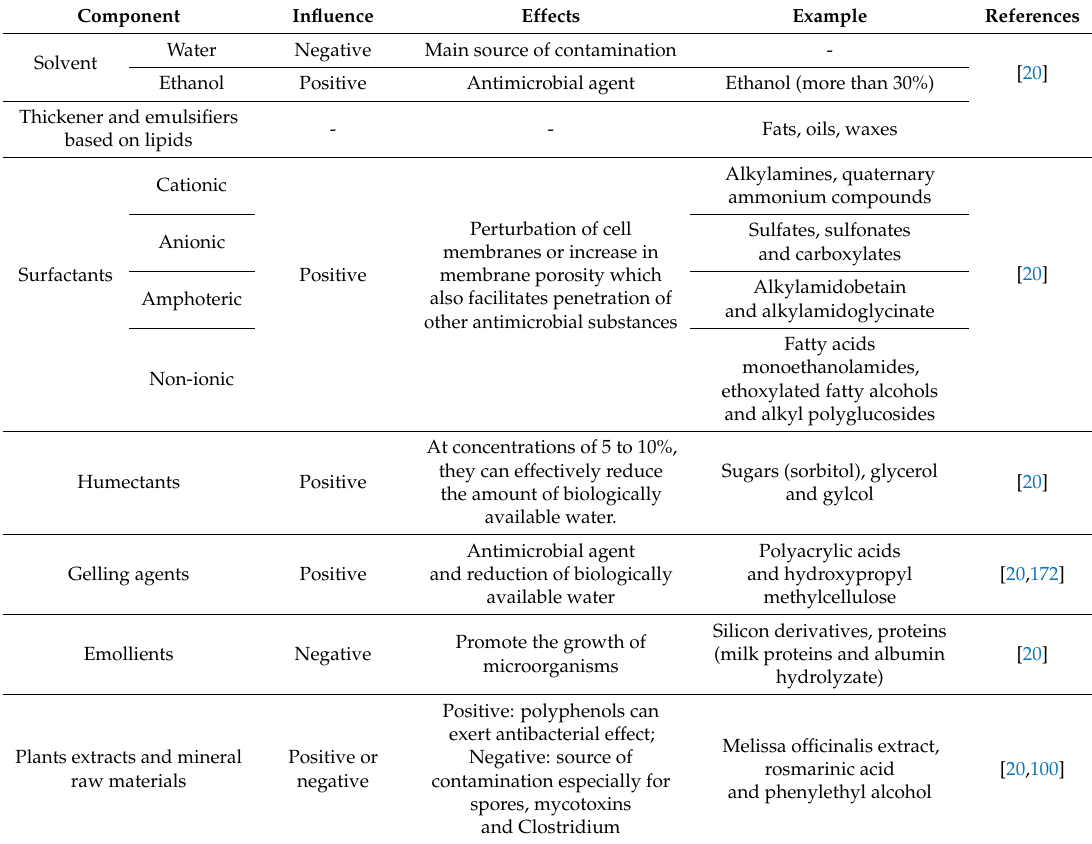
Table 2. Influence of some cosmetic constituents on